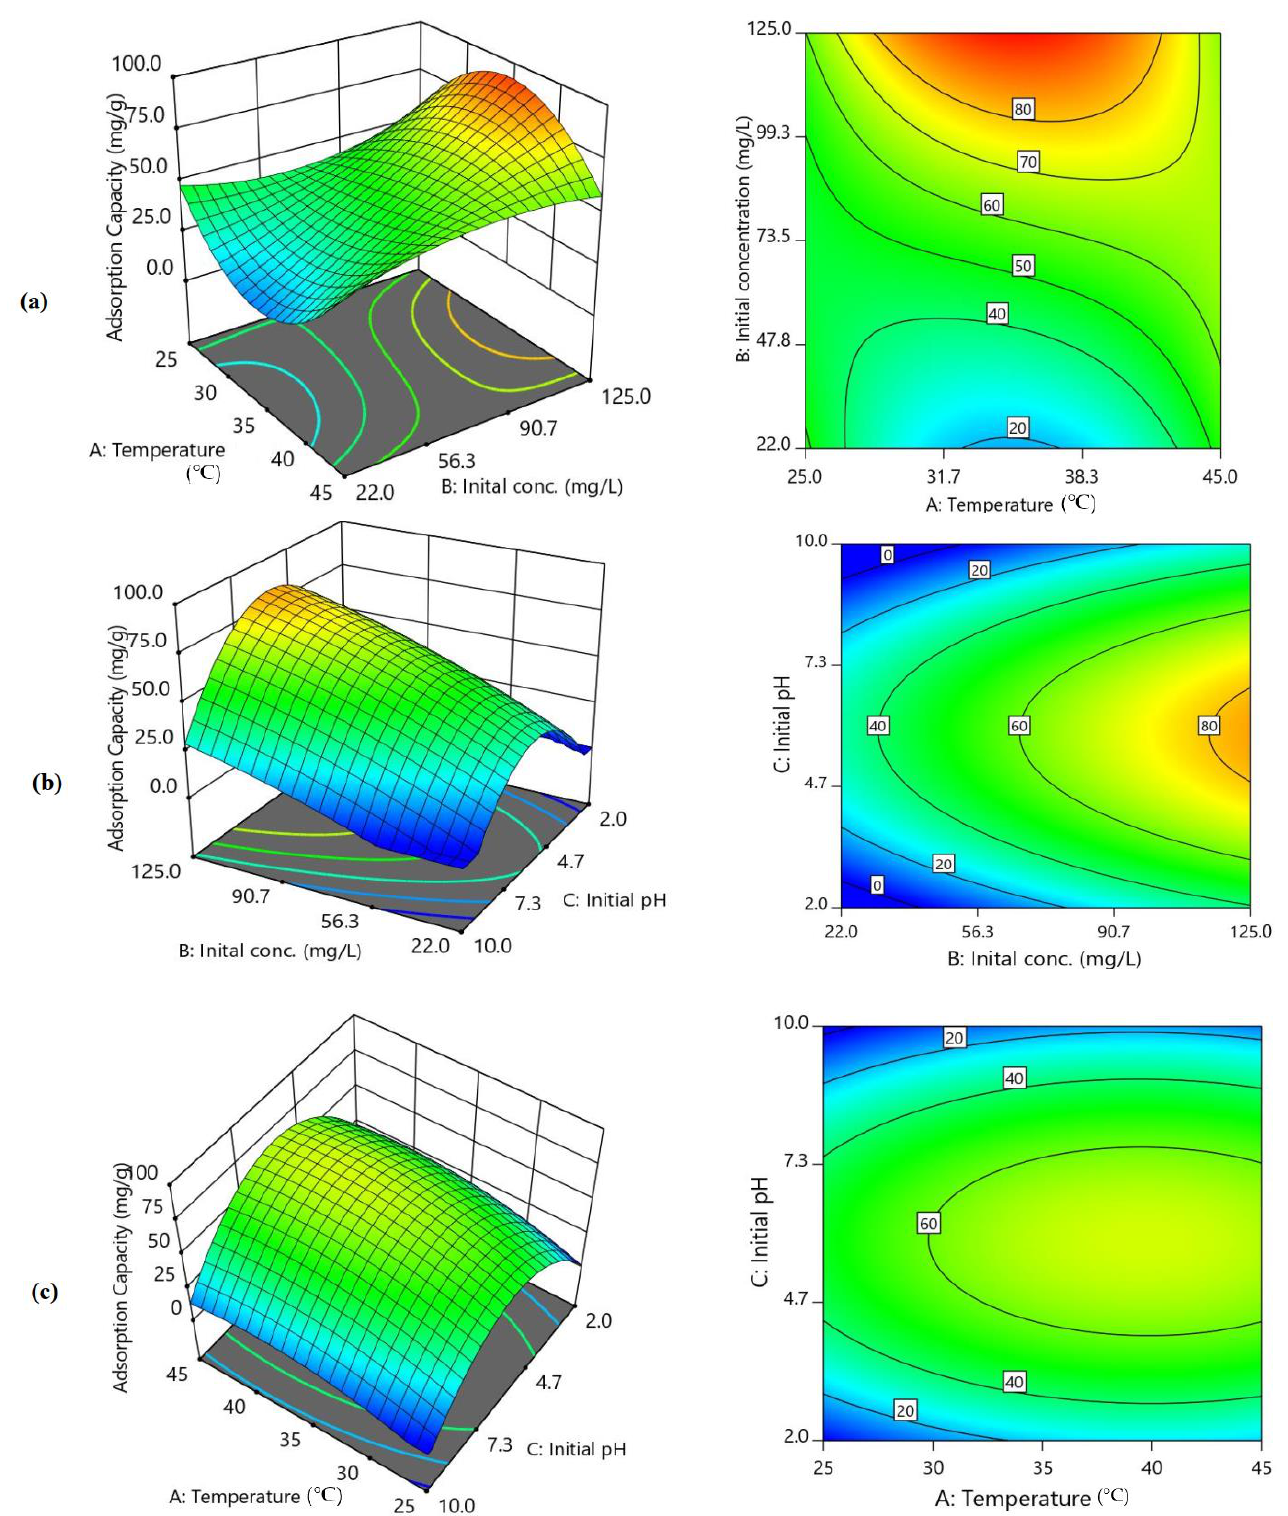
Figure 4. Effect of ( a ) Temperature vs. initial concentration at fixed pH 6, ( b ) Initial concentration vs. initial pH, ( c ) Temperature vs. initial pH on SBAC-MgAlFe capacity for phenol uptake.